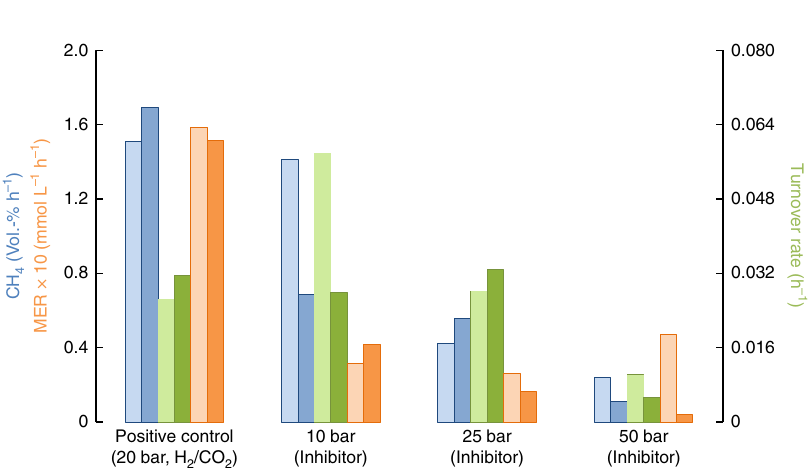
Fig. 4 CH 4 production, MER, and turnover rate of M. okinawensis under Enceladus-like conditions at high pressure. Biological CH 4 production determined by gas chromatography (blue) (Vol.-% h − 1 ) and turnover rates (h − 1 ) (green) and MER · 10 (mmol L − 1 h − 1 ) (red) measured from headspace gas conversion using M. okinawensis (experiment 1 in light colours, experiment 2 in dark colours) under putative Enceladus-like conditions in a 2.0 L bioreactor (for detailed medium composition, see Supplementary Table 3 and for detailed gas composition see Table 4, n = 2). The positive control experiment contained also the liquid inhibitors but only H 2 /CO 2 (4:1) in the headspace. For high-pressure experiments without any inhibitors see Supplementary Fig.